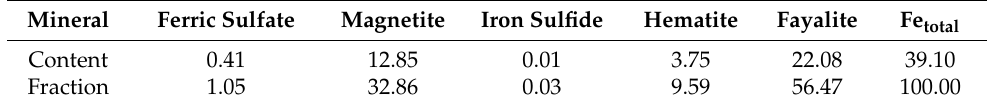
Table 2. The distribution of iron in associated minerals (wt. %). Table 3. The distribution of copper in associated minerals (wt.